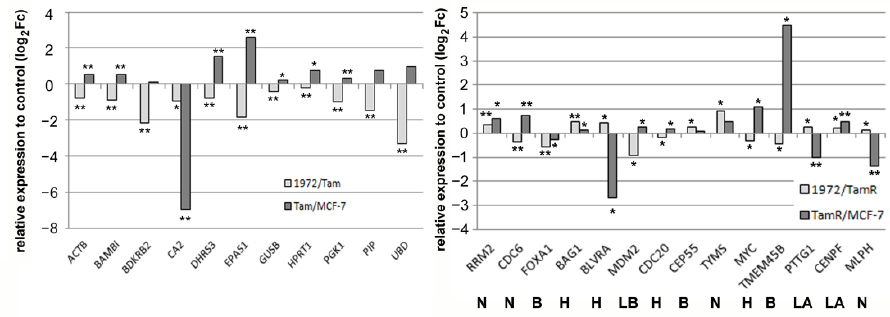
Figure 4. Significant changes in gene expression induced by miR-1972 mimic transfection compared to control transfections as determined by the nCounter technique. Only genes that are significantly changed in the TamR cell line are shown. Left: Tam-gene set. Right: pam50 gene set. N: normal-like, B: basal-like, H: HER2-enriched, LB: luminal B, LA: luminal A. ** p < 0.01, * p < 0.05.